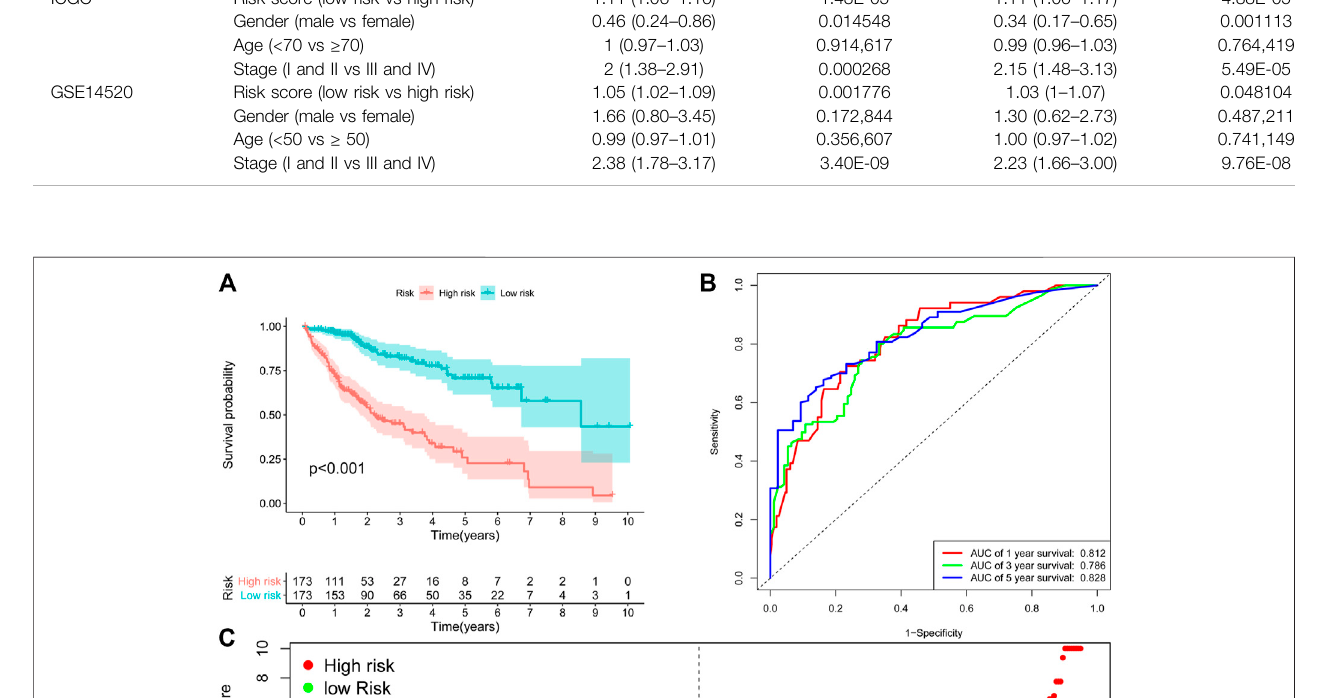
listed in Table 2 .